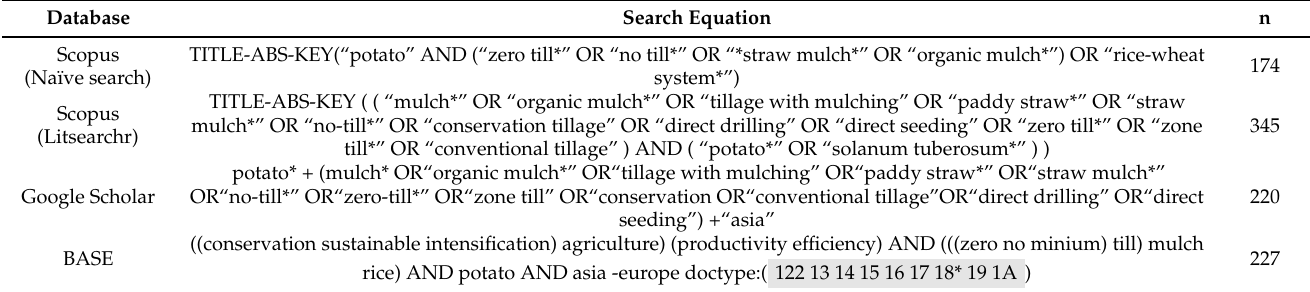
Table 1. Search equations performed at each database used in this review. In gray, the codes refer to document types in BASE database search query. n—number of